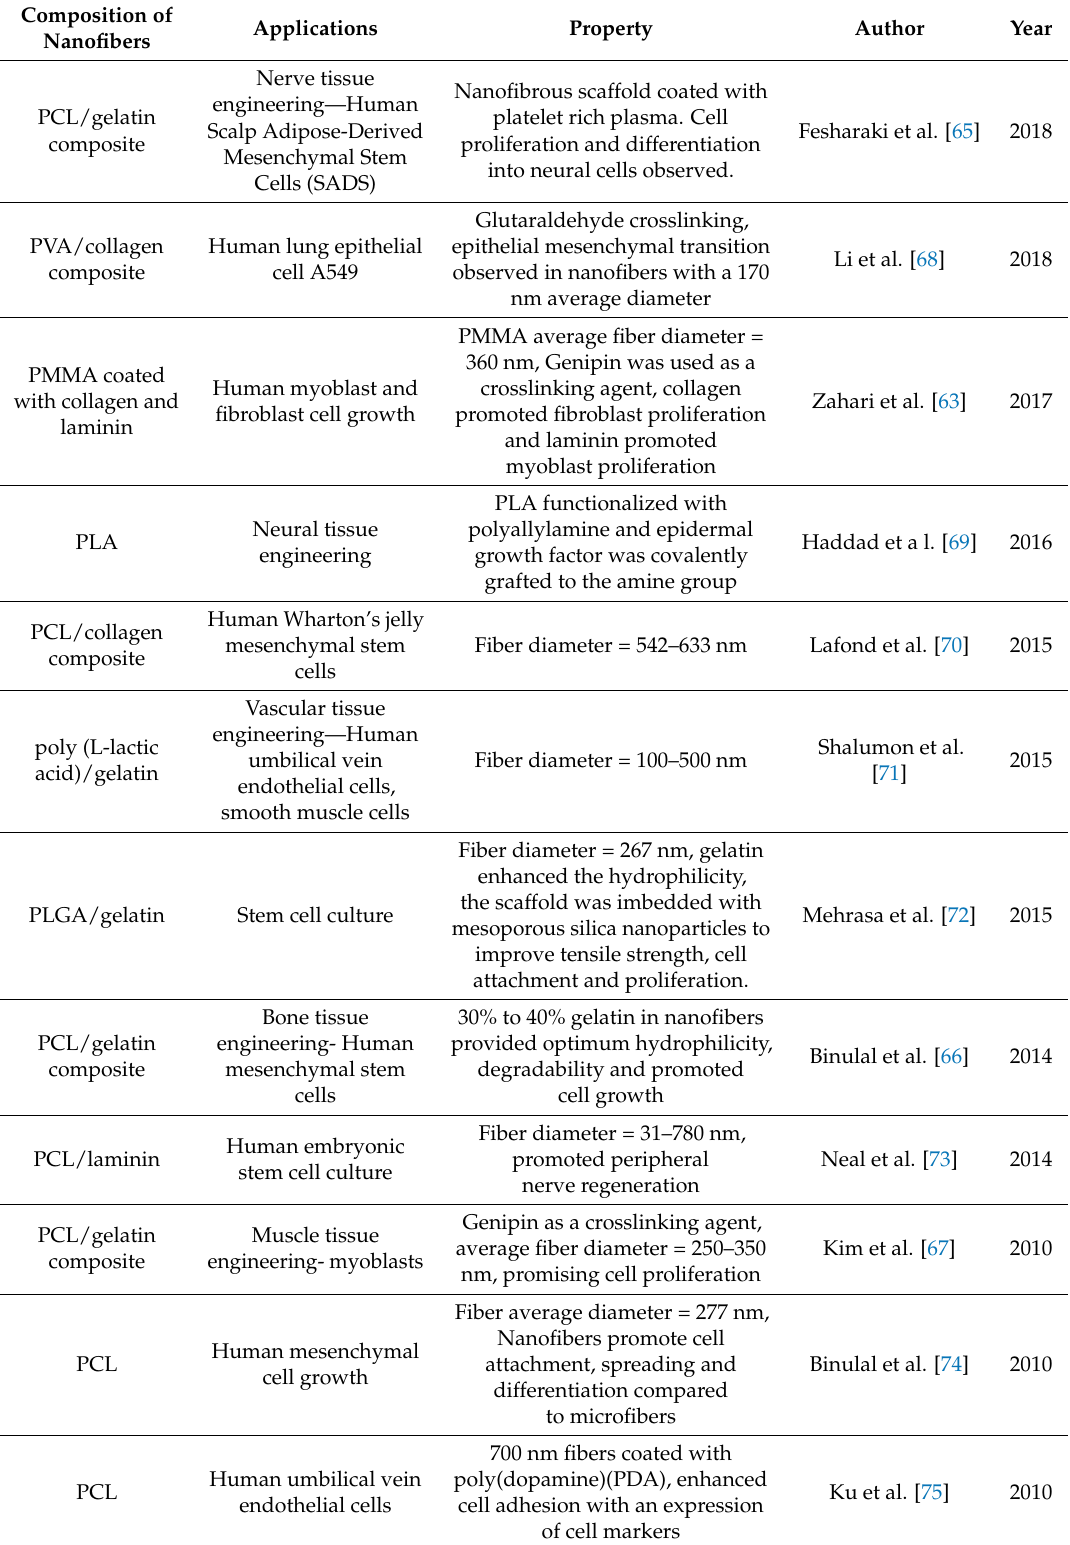
Table 1. Examples of electrospun nanofibrous scaffold for tissue engineering purpose, the polymers used along with the properties and application of the